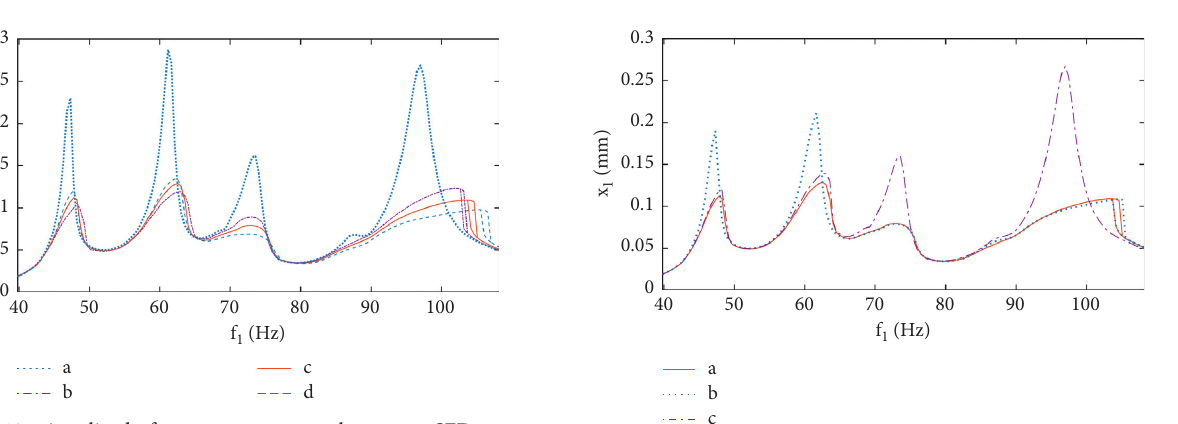
Figure 12: Amplitude-frequency curves when two SFDs are implemented on the front and the rear bearing of the low-pressure shaft with different sets of clearances (a: no SFD, b: 0.22mm and